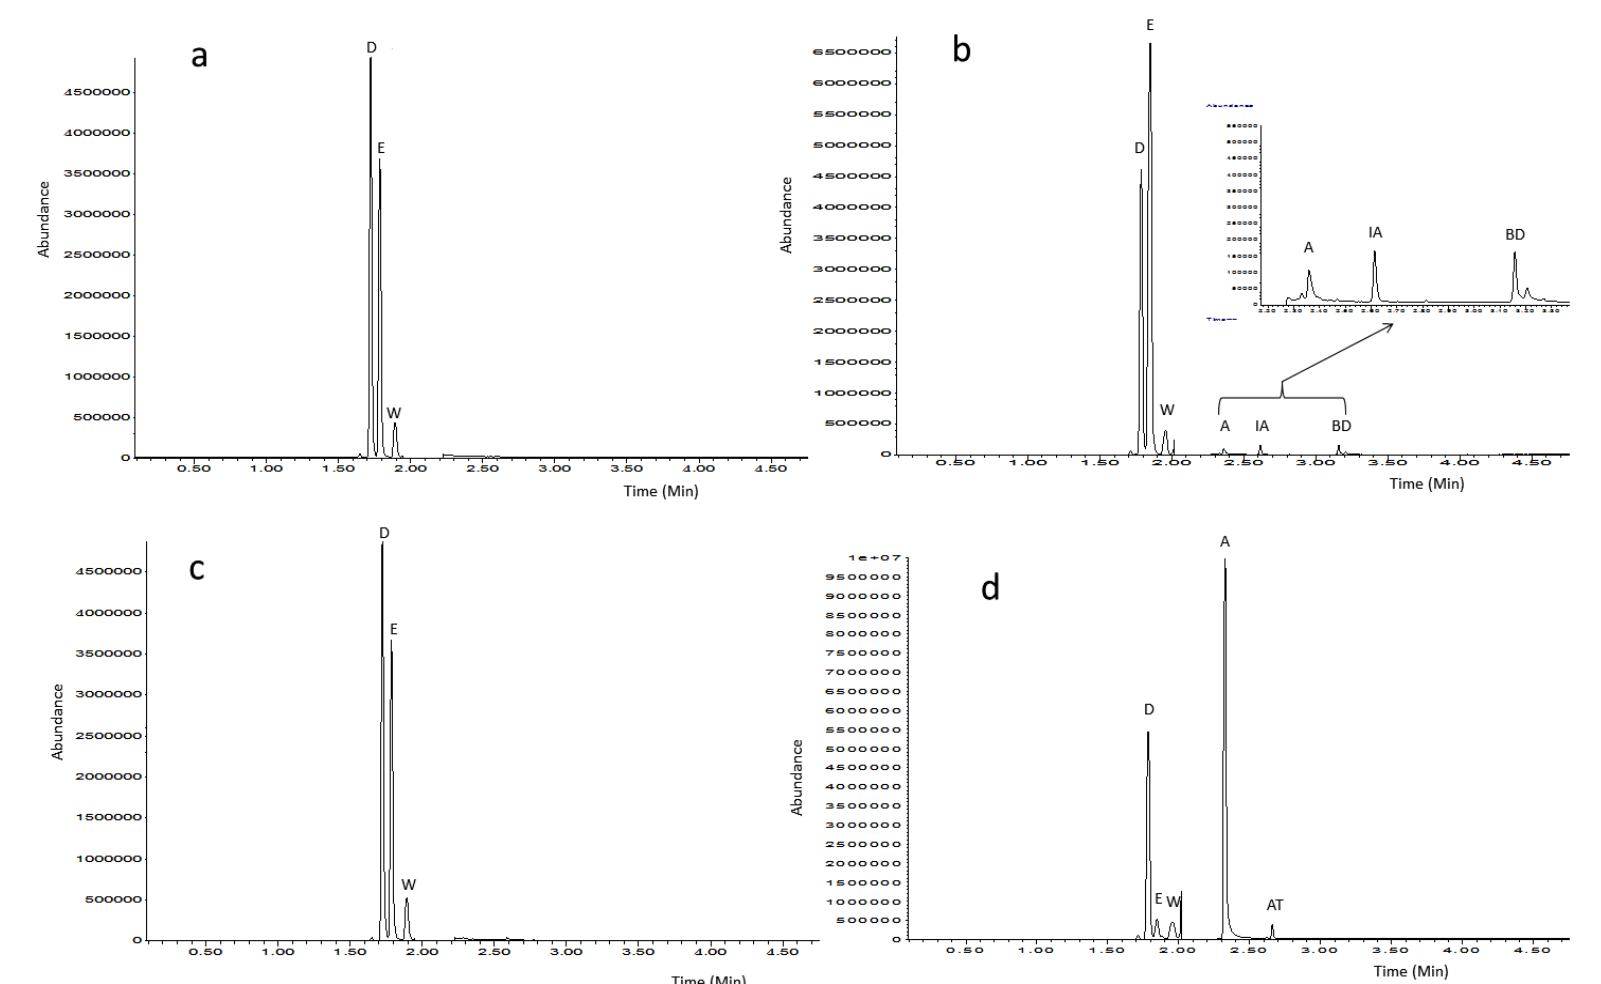
Figure 2. Typical gas-chromatography-mass spectrometry (GC-MS) chromatograms obtained from the analysis of beer ( a ), wine ( b ), whisky ( c ) and vinegar ( d ) ethyl acetate extracts. D = D 4 -methanol, E = ethanol, W = acetonitrile (from wash solvent), A = acetic acid, IA = isoamyl alcohol, BD = 2,3-butanediol and AT = acetoin.